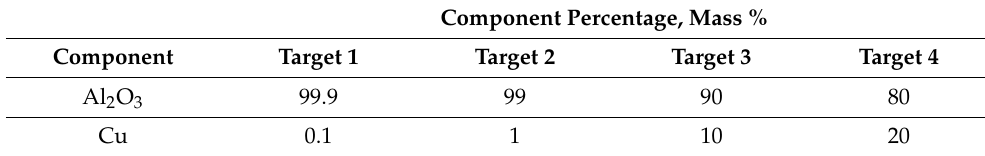
Table 1. Component composition of Al 2 O 3 -Cu targets.